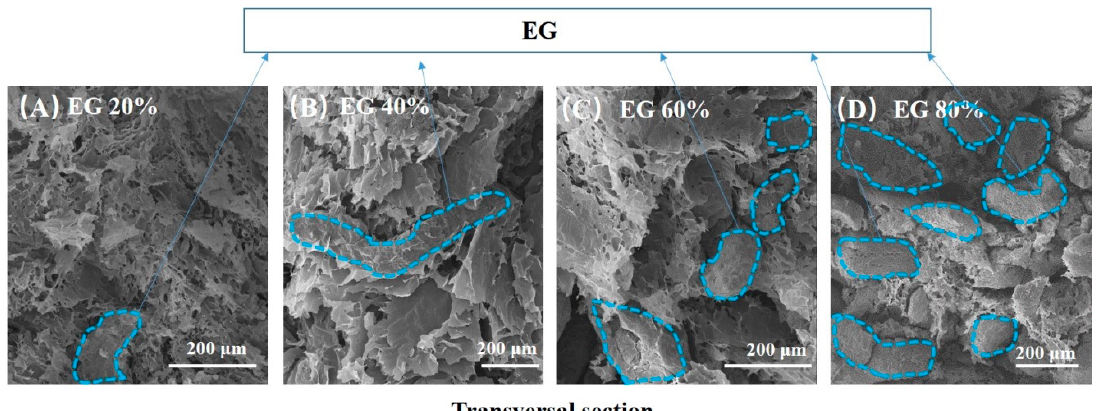
Figure 3. SEM photos of the transversal section of anisotropic rGO/EG aerogel with EG content of 20% ( A ), SEM photos of the transversal section of anisotropic rGO/EG aerogel with EG content of 40% ( B ), SEM photos of the transversal section of anisotropic rGO/EG aerogel with EG content of 60% ( C ), SEM photos of the transversal section of anisotropic rGO/EG aerogel with EG content of 80% ( D ).